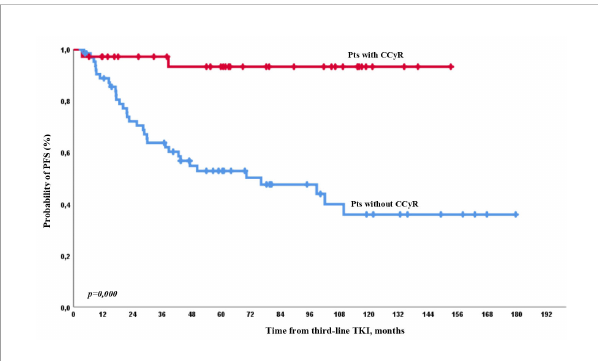
FIGURE 5 PFS on third-line therapy according to CCyR achievement on third- line